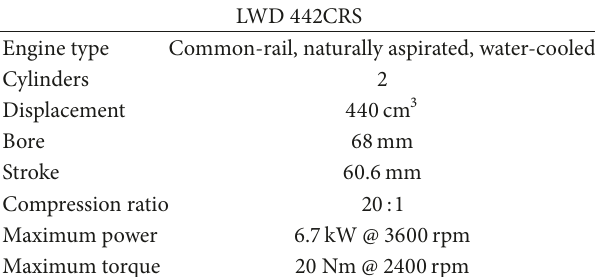
Table 1: Engine specifications.